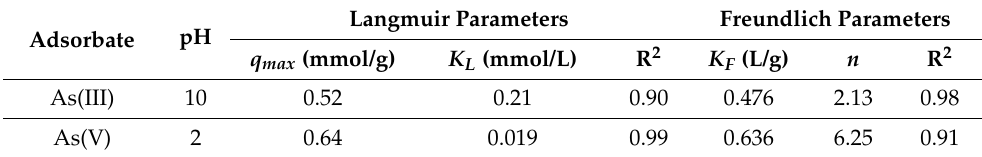
Table 2. Langmuir and Freundlich parameters for As(III) and As(V) adsorption isotherms on the iron precipitates generated by the microbial